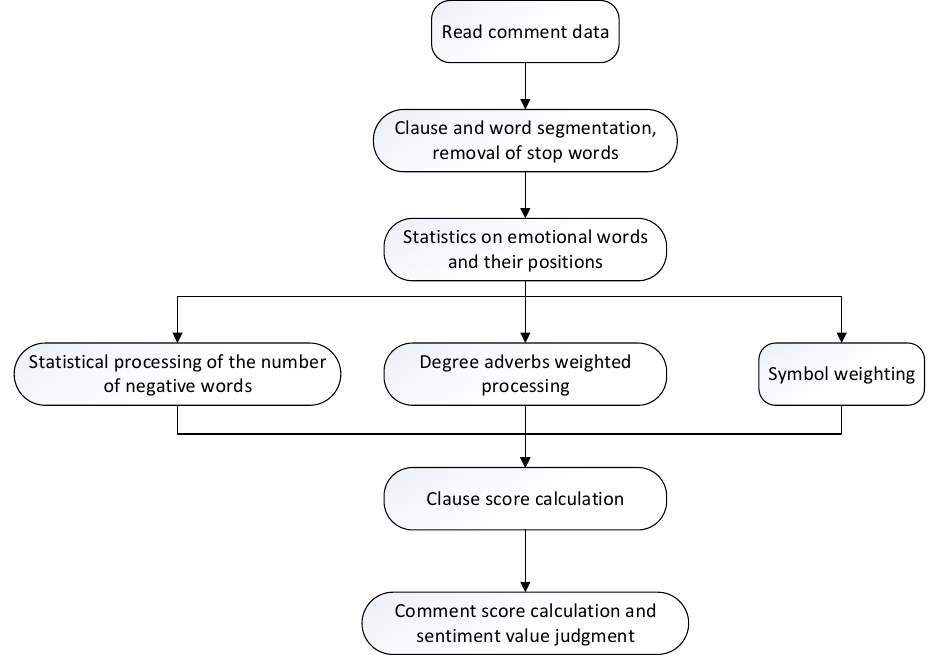
Figure 3. The calculation process of a sentiment value.